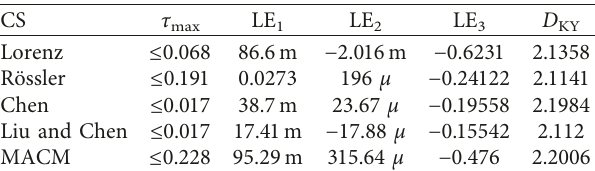
Table 4: Analysis of chaos degradation for DV of 3D CSs by using the NA of Heun (7) and (8).